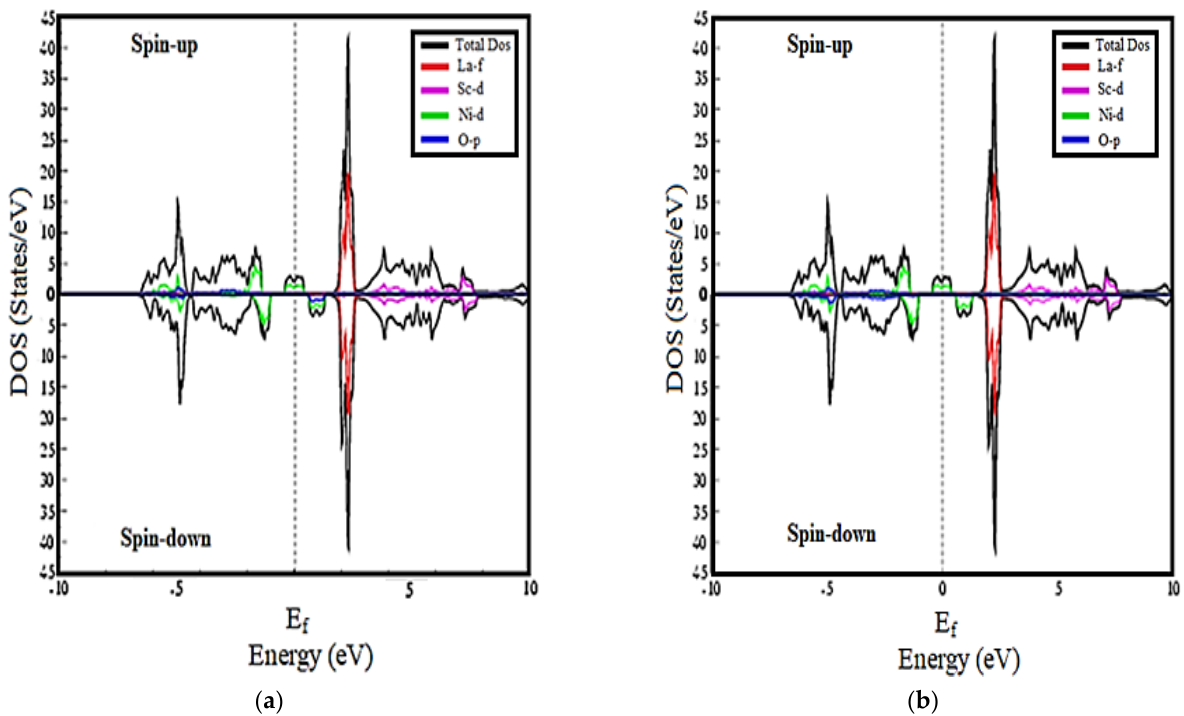
Figure 6. Density of states (DOS) of La 2 ScNiO 6 using ( a ) GGA and ( b ) GGA+U.